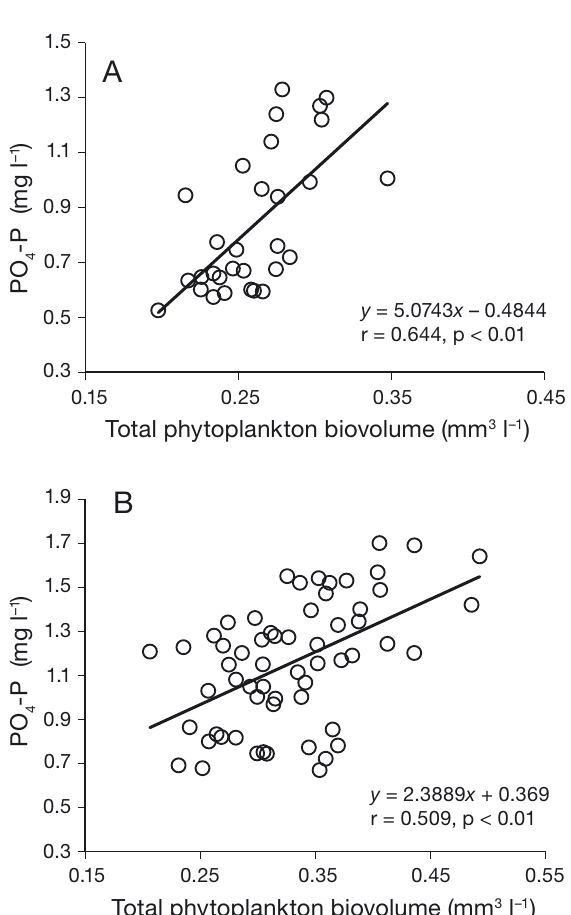
Fig. 5. Relationship between PO 4 -P concentration and total phytoplankton biovolume in ponds (A) without and (B) with common carp (Cyprinus